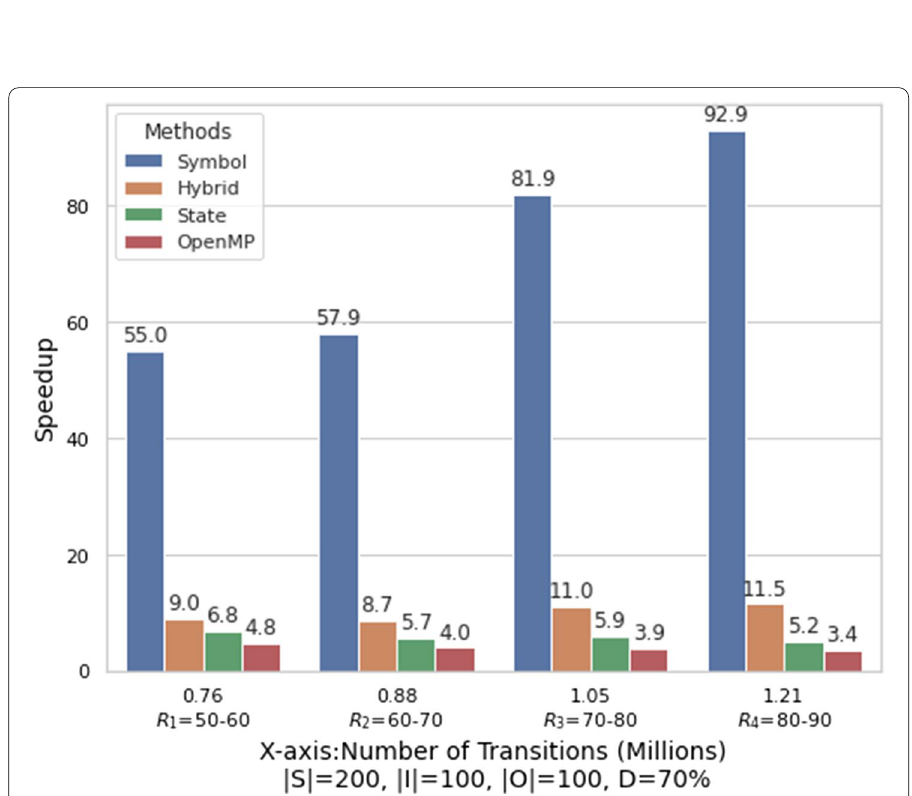
Fig. 12 Achieved speedup while varying range of